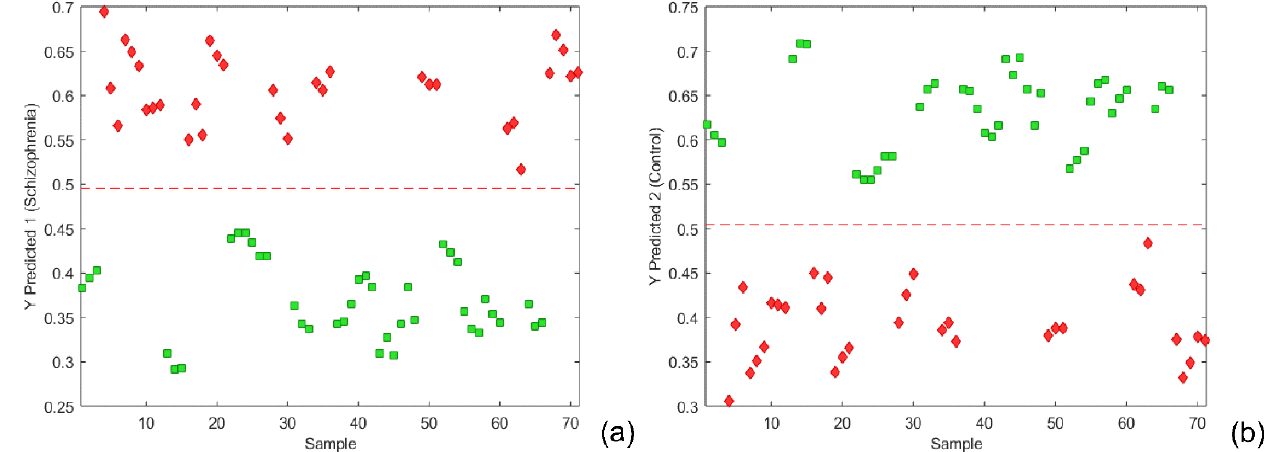
Figure 4. ( a ) Y predicted for the class ‘Schizophrenia’. ( b ) Y predicted for the class ‘Control’ from an external test dataset using class centroid centering and scaling. The schizophrenia cohort is shown in red, and the control group in green.